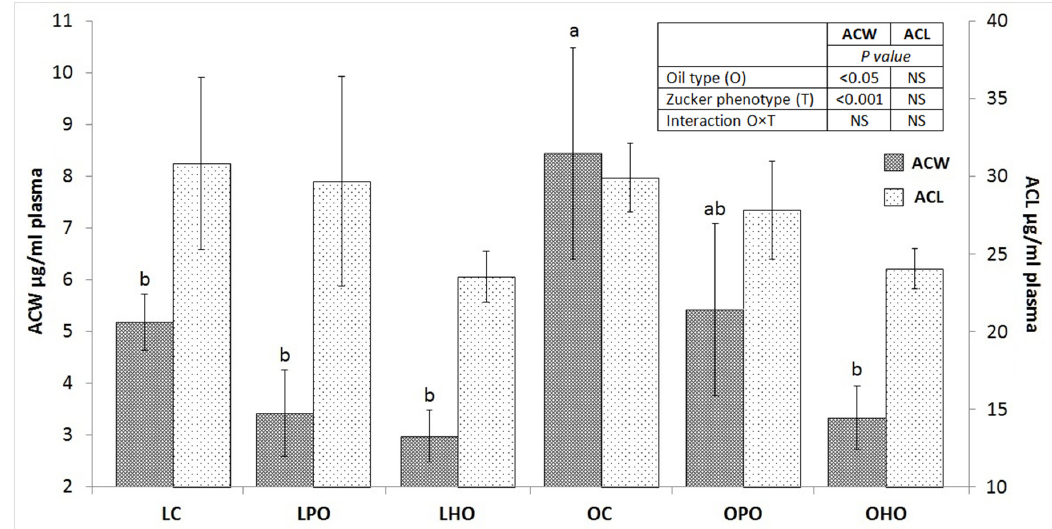
Figure 1. Plasma ACW and ACL levels in Zucker rats fed experimental diets. Values are the mean ± SEM, where n = 6 for obese rats and n = 8 for lean rats. Means without a common letter differ, p ≤ 0.05. LC, lean rats fed a control diet with palm oil; LPO, lean rats fed a diet with poppy seed oil; LHO, lean rats fed a diet with hemp seed oil; OC, obese rats fed a control diet with palm oil; OPO, obese rats fed a diet with poppy seed oil; OHO, obese rats fed a diet with hemp seed oil; ACW, antioxidant capacity of water-soluble substances; ACL, antioxidant capacity of lipid-soluble substances.